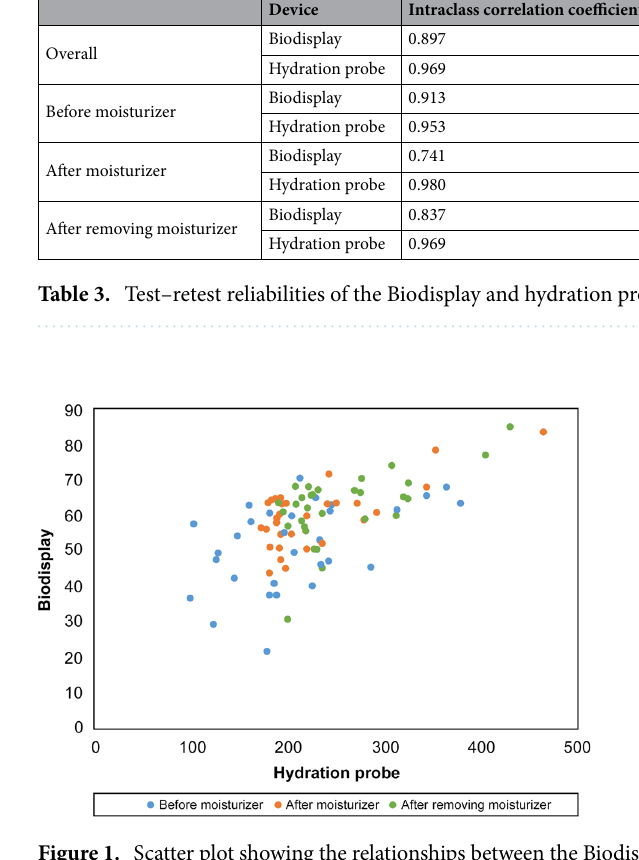
Figure 1. Scatter plot showing the relationships between the Biodisplay and hydration probe. Moderate correlation was observed between the two modalities (PCC = 0.601, p <